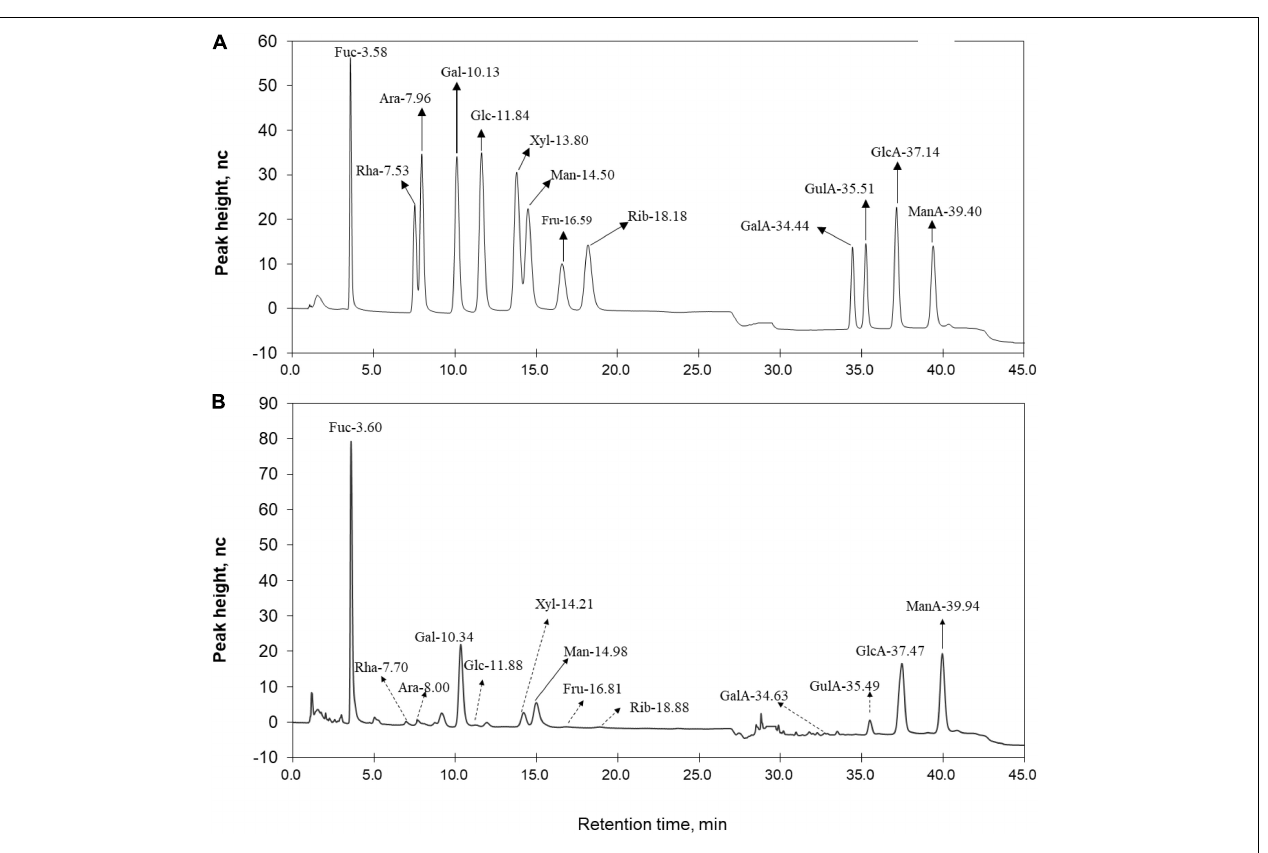
FIGURE 2 | Ion chromatogram of (A) standard monomers and (B) LJPS. Each absorption peak was annotated based on the monomer name and retention time. Monomers with a molar proportion less than 5% were annotated with dotted